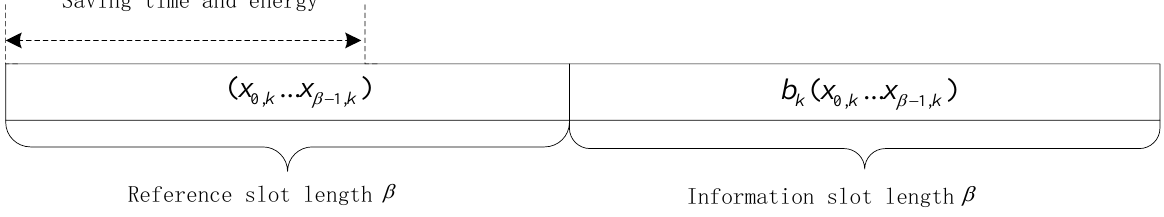
Figure 2. Frame structure of the DCSK system.